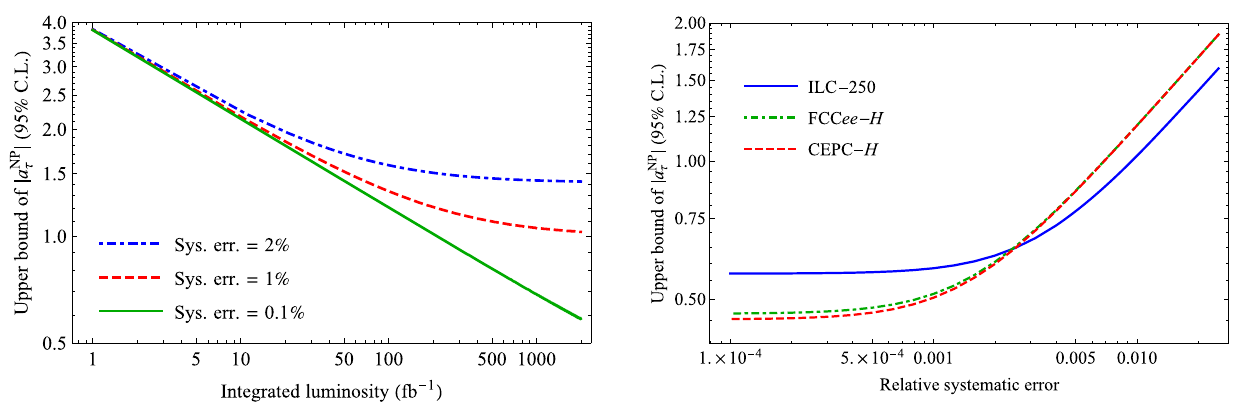
Fig. 5 The 95% CL upper bound of a NP τ as a function of the inte- grated luminosity at the ILC-250 experiment for three cases in which the relative systematic errors are 2, 1, and 0.1%, respectively